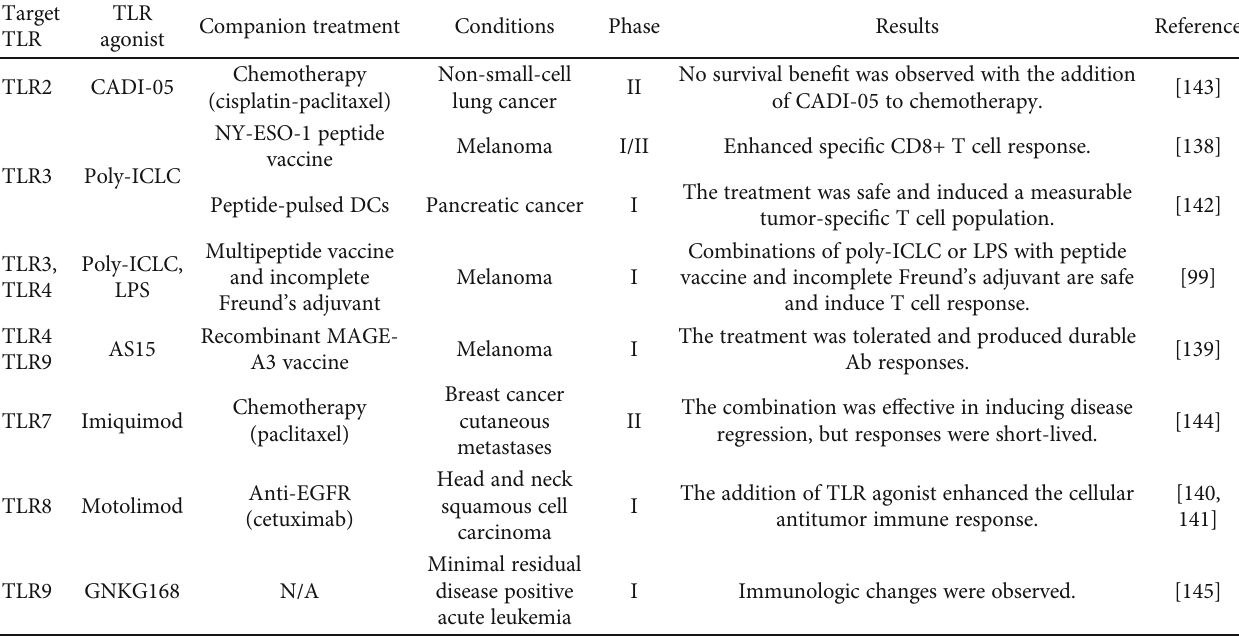
Table 2: Clinical studies on the application of TLR agonists for cancer treatment published since 2016.